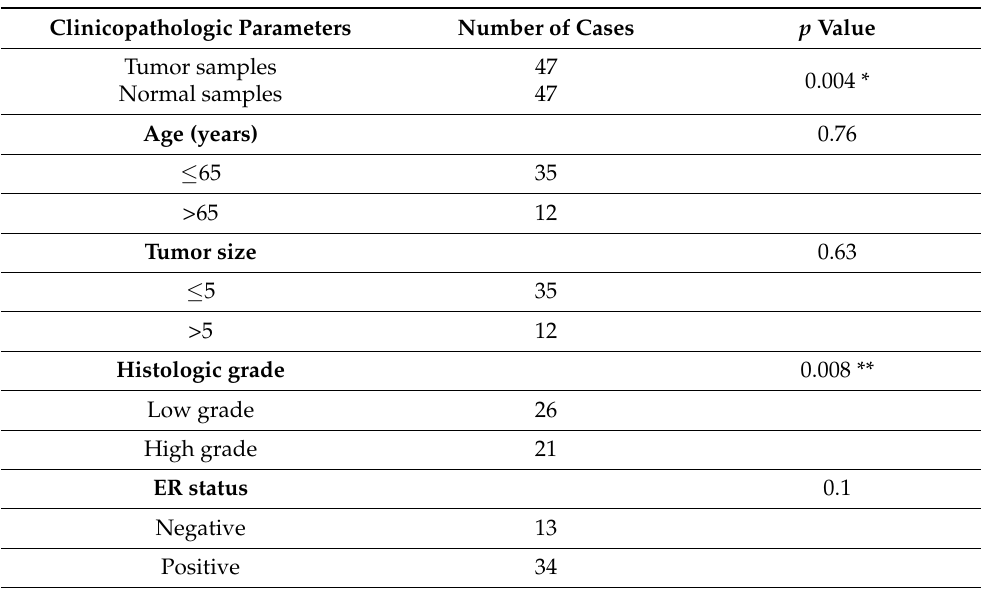
Figure 1. PNKY is upregulated in breast cancer. ( A ) PNKY transcript was detected in several tumor tissue types, including breast, brain, prostate, and colorectal cancer tissues using RT-PCR. Because PNKY has one exon, a no-RT control was performed for each sample in parallel to detect any potential contamination with genomic DNA. ( B ) PNKY is significantly overexpressed in breast tumor samples compared with non-tumoral breast tissues; therefore, its expression is significantly upregulated in high-grade breast tumors. ( C ) Bar charts indicate that PNKY is upregulated in ER, PR, Her2 negative, and P53 positive tumor samples. The values shown represent the mean ± SE. ** p value < 0.01. Table 1. Co-relationship between PNKY expression level and clinicopathologic characteristics of breast cancer tissues.